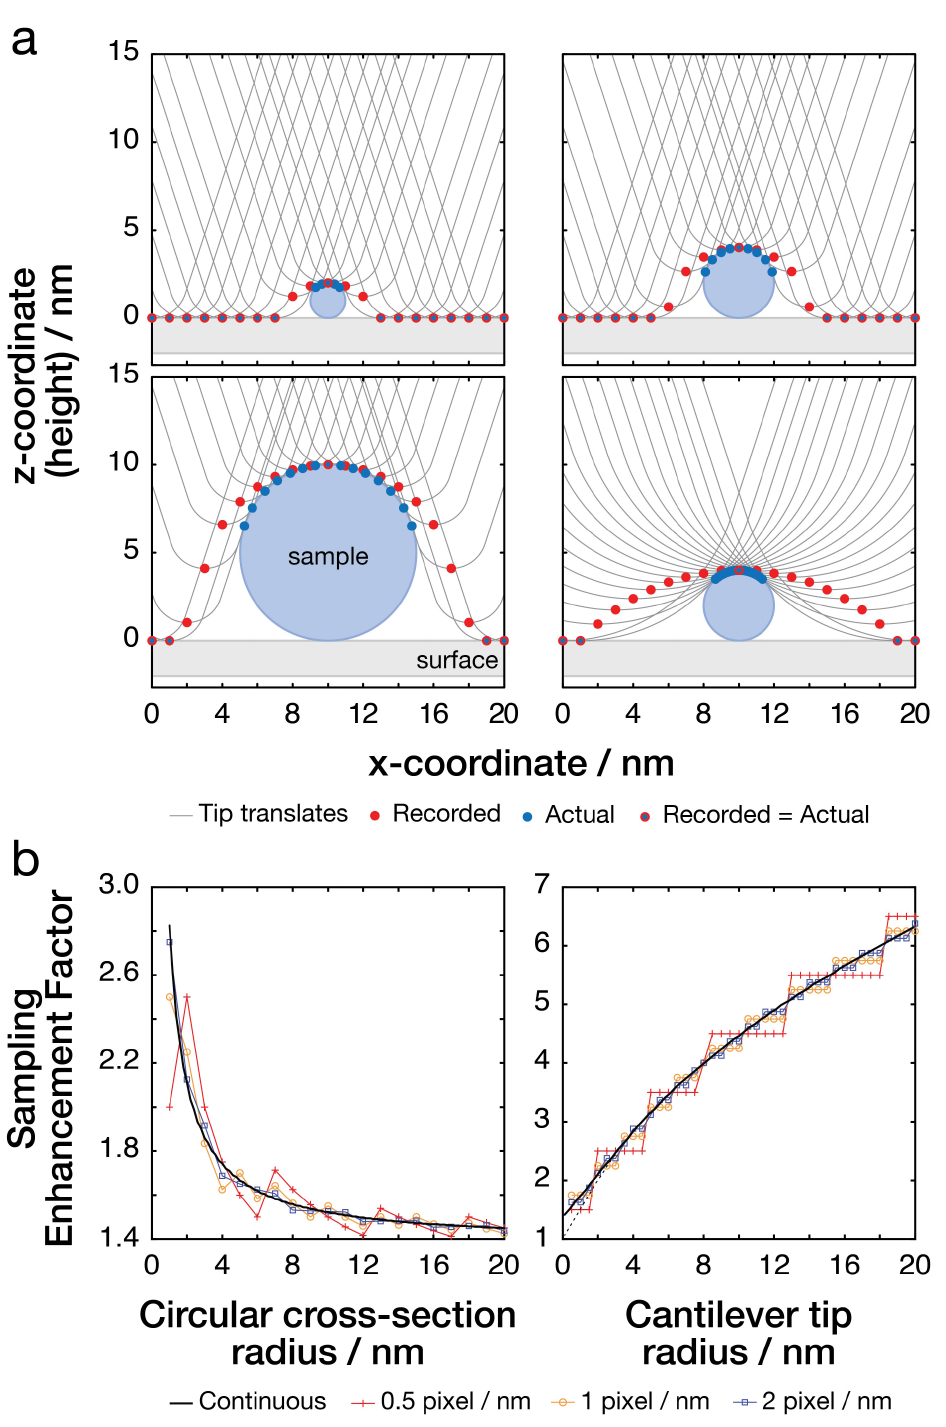
Figure 3: Image sampling enhancement effect after image correction by contact-point deconvolution shown with varying sample and sampling parameters. Schematic diagrams are shown in (a) and results from simulations in (b). Red circles on schematics represent original convoluted coordinates at each sampled pixel and blue circles represent tip-sample contact points at each sampled pixel. The sampling enhancement factor is defined as the ratio of pixel density of these points within the circle envelope. Left column shows the enhancement effect seen with a circle with varying radius. A symmetric conical tip model with a radius of 2 nm and tip side-angle of 18° was used. Right column shows the enhancement effect observed with a circle with a constant radius of 2 nm with varying tip radius and a tip side-angle of 18°. The dashed line represents the same simulation but with a tip with side-angle of